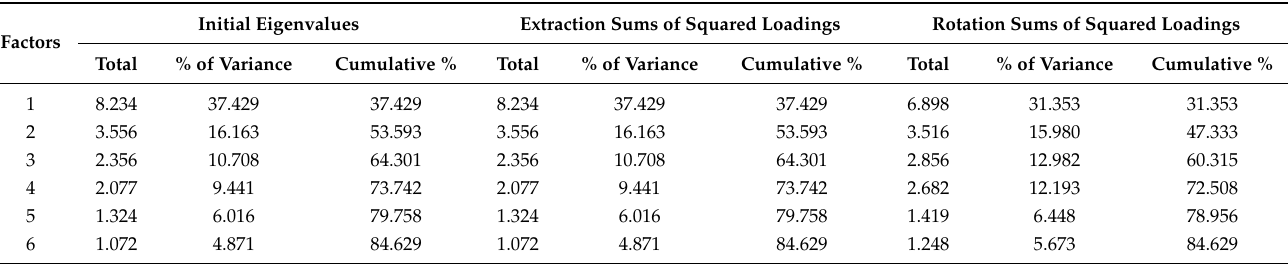
Table 3. Rotation in sums of squared loadings.